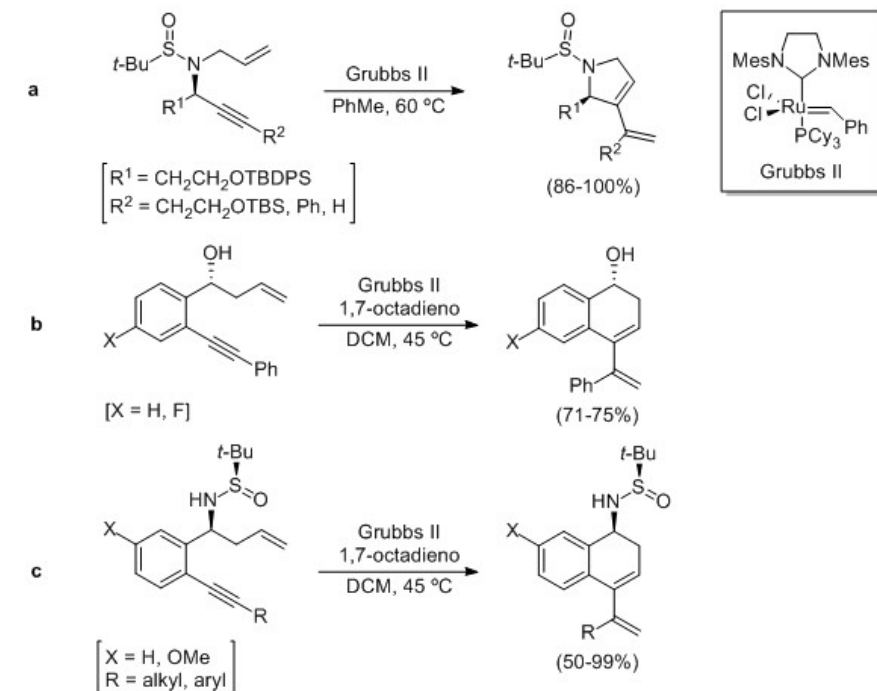
Figure 1 - Examples of ring-closing metathesis in N - tert -butasulfinamides bearing enyne moiety